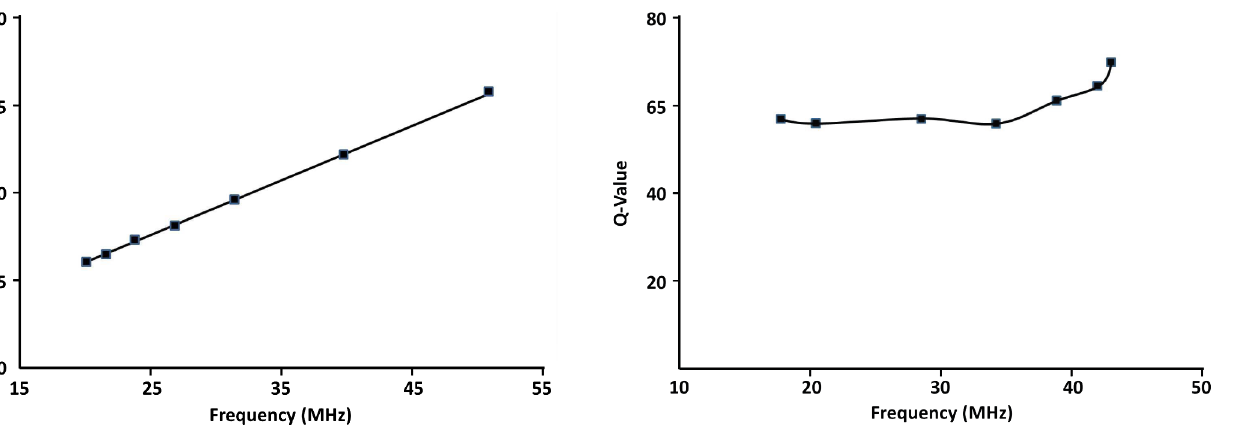
FIG. 26. Frequency dependence of cavity gap